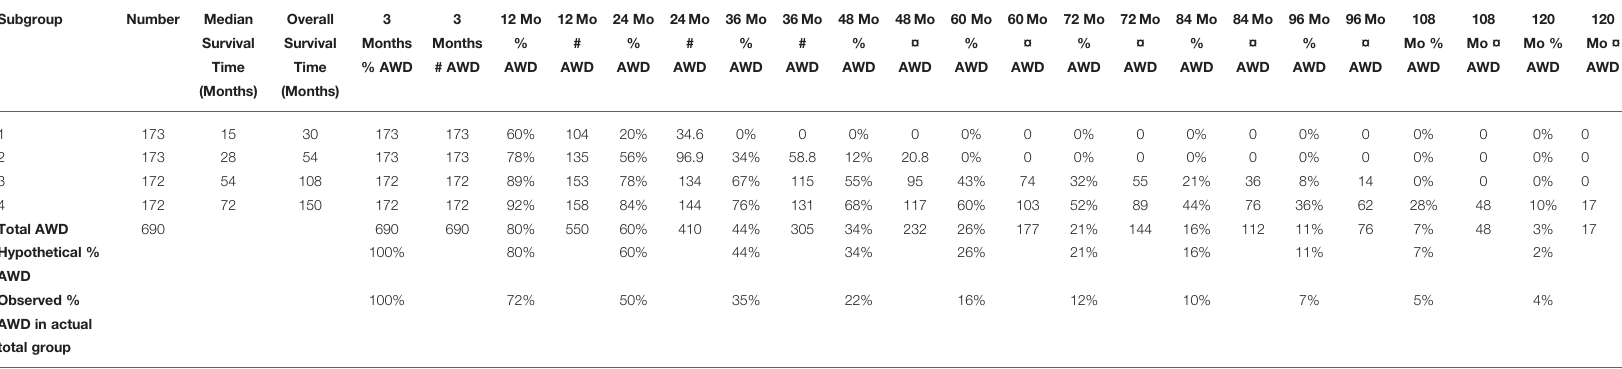
TABLE 1 | The total number of 690 patients and the characteristics of the 4 hypothetical subgroups, derived from Figures 7 – 9 . Subgroup